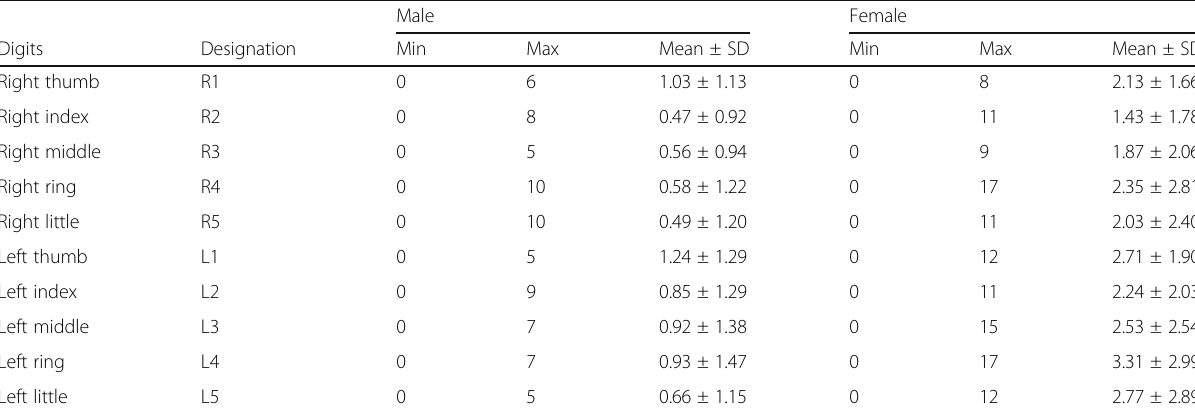
Table 1 Descriptive statistics of the FWLC of the right and left hands digits